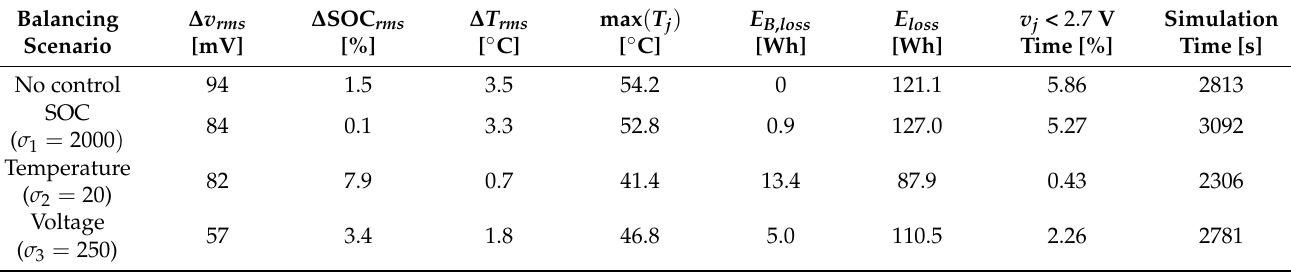
Table 3. Key metrics of single controllers results shown in Figure